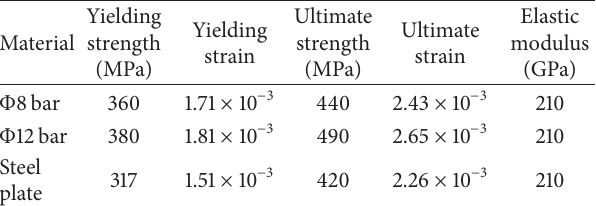
Table 3: Materials properties of bars and steel plate.